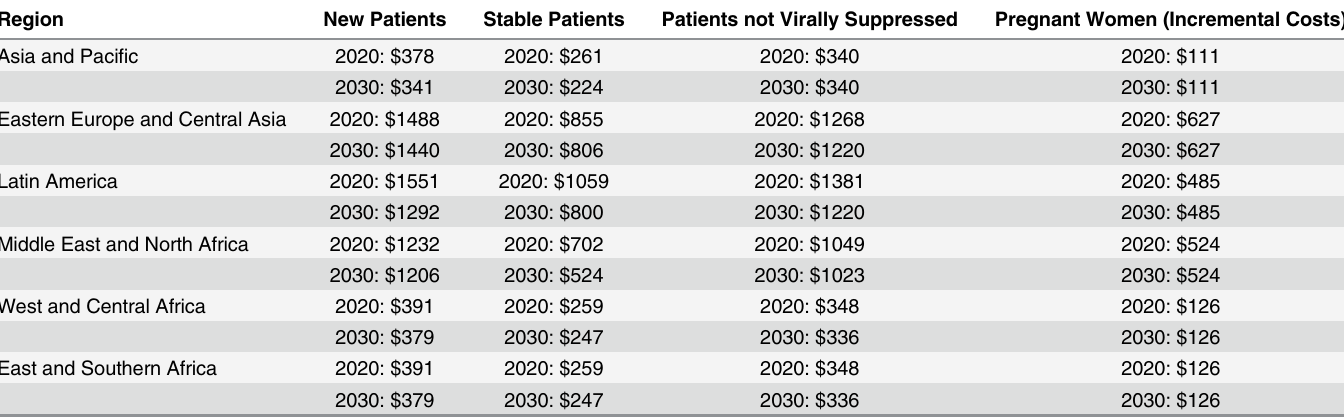
Table 4. Future costs of antiretroviral treatment, for different categories of patients, by